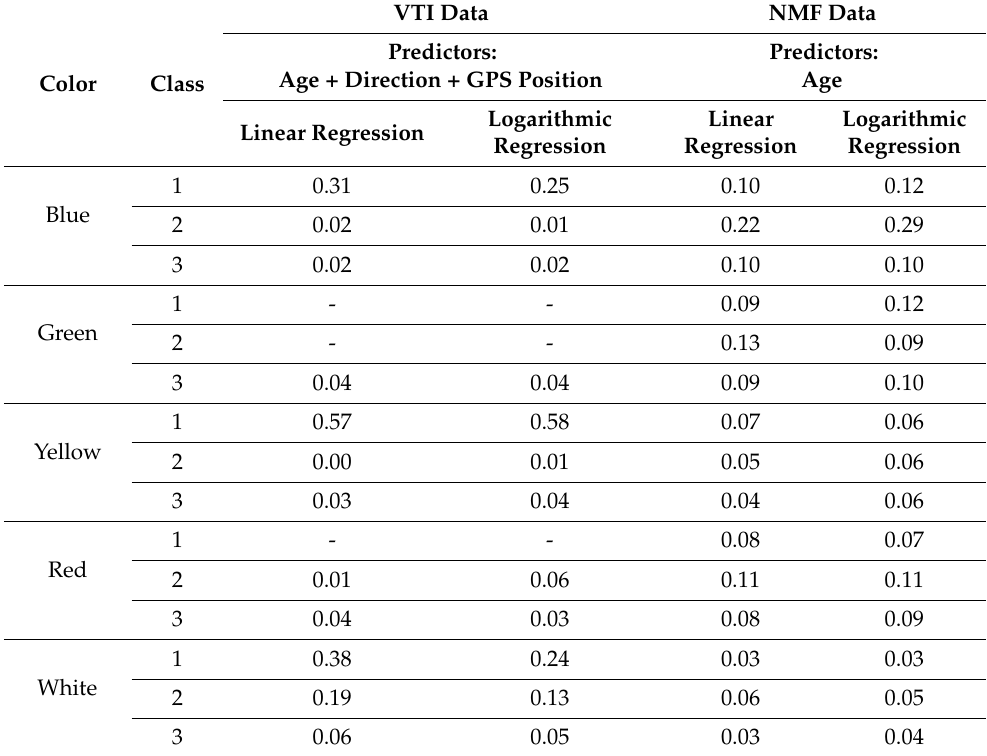
Table 9. R 2 values for VTI and NMF regression models for each color and class.